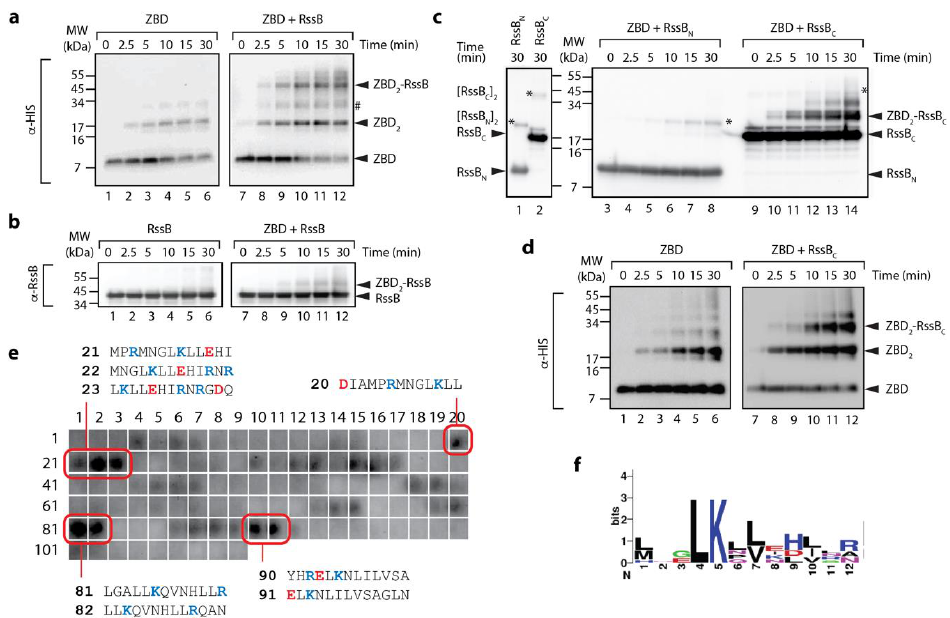
Figure 2. The ZBD of ClpX interacts with C-terminal domain of RssB. ( a , b ) The interaction of the ZBD of ClpX with itself (lanes 1–6) or RssB (lanes 7–12) was examined by chemical crosslinking using 0.005% ( v / v ) glutaraldehyde (GA). Following crosslinking, proteins were separated by SDS-PAGE, transferred to PVDF membrane and probed with ( a ) anti-His antisera (for ZBD) or ( b ) anti-RssB (for RssB). In the absence of any additional proteins, the ZBD of ClpX assembled into dimers (lanes 1–6). Following the addition of RssB to ZBD (in the presence of GA) a specific crosslinked protein band (ZBD-RssB) of ~45 kDa was observed by immunodecoration using ( a ) anti-His antisera and ( b ) anti-RssB antisera. # represents a non-specific crosslink of 2 ZBD dimers. ( c ) The ZBD of ClpX forms a specific crosslink with RssB C . Following crosslinking, proteins were separated by SDS-PAGE, transferred to PVDF membrane and probed with anti-RssB antisera. In the absence of the ZBD, RssB N (lane 1) and RssB C (lane 2) form dimers (indicated by *). In the presence of the ZBD of ClpX, a specific crosslink to RssB C (lanes 9–14) and not to RssB N (lanes 3–8) was observed. ( d ) The ZBD of ClpX forms a specific crosslink with RssB C . To confirm the presence of ZBD, reactions were probed with anti-His antisera. In the absence of RssB C , the ZBD formed dimers (lanes 1–6). Following addition of RssB C an additional crosslinked protein band (ZBD 2 -RssB C ) was observed (lanes 9–12). ( e ) The ZBD interacts with 13-mer peptides in RssB (numbering refers to peptide spots, sequences of “strong” binding peptides are indicated). ( f ) Weblogo representation of the consensus motif for “strong” binding peptides to the ZBD of